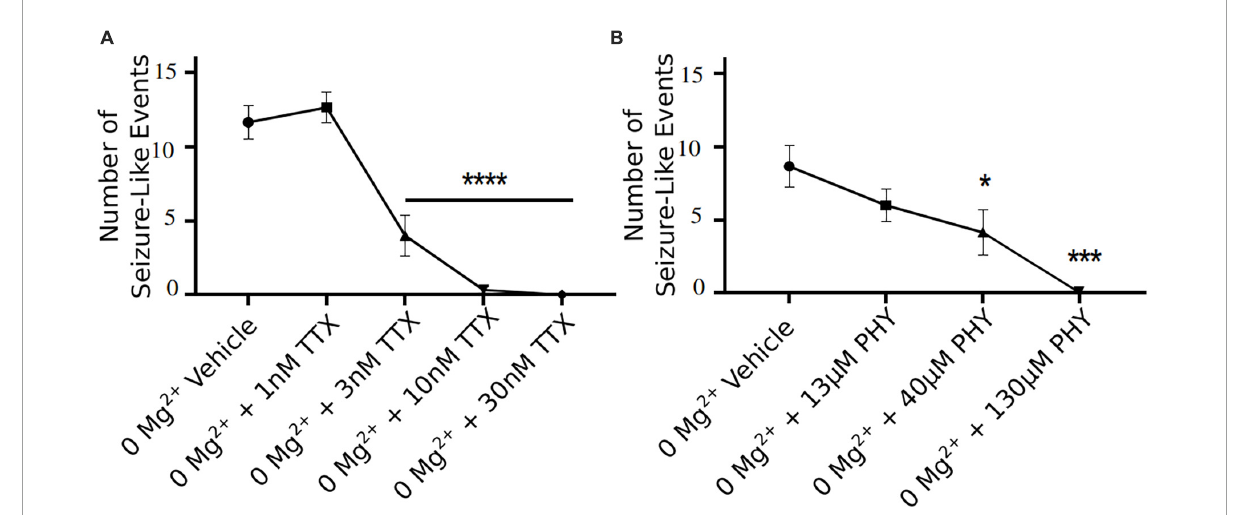
FIGURE6 TTX and phenytoin (PHY) reduces seizure-like events in a clear concentration dependent manner. Seizure-like events are reduced in a TTX (A) and PHY (B) concentration-dependent manner (one-way ANOVA with a Dunnett’s test, * p < 0.05, *** p < 0.001, **** p < 0.0001, n = 6 for TTX n = 5–7 for